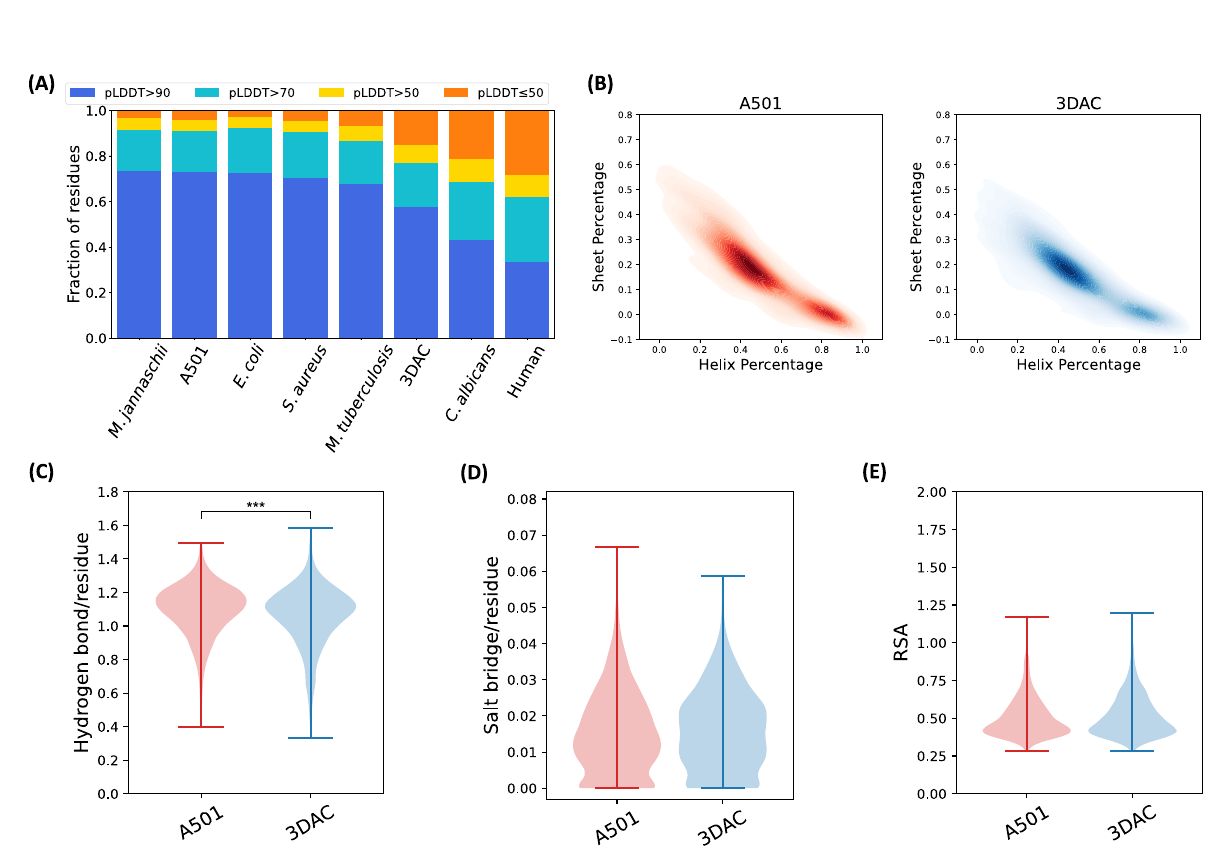
Fig.1|Work fl owandbasiccharacteristicsofA501(red)and3DAC(blue)inthis study. A Schematic diagram of the AlphaFold2-based proteome-wide structure prediction wasused inthis study. B Phylogeneticpositions of theZhurongbacteria superfamily and Thermococcales to which 3DAC and A501 belong. “ + ” represents conserved in ortholog or structure or function; “ − ” represents not conserved; “ ± ” representsinsomecasesthe activesiteisconservedbutinmostcasesnot. “ ABCA ” represents the archaeal-bacterial common ancestor. “ Arc-Bac divergence/tem- perature adaptation ” means independent evolution after the division of archaea and bacteria or according to temperature adaptation. “ LUCA ” represents the last universal common ancestor. C Growth features in the temperature range of A501 and 3DAC. Error bars represent the standard deviations (SDs) from independent